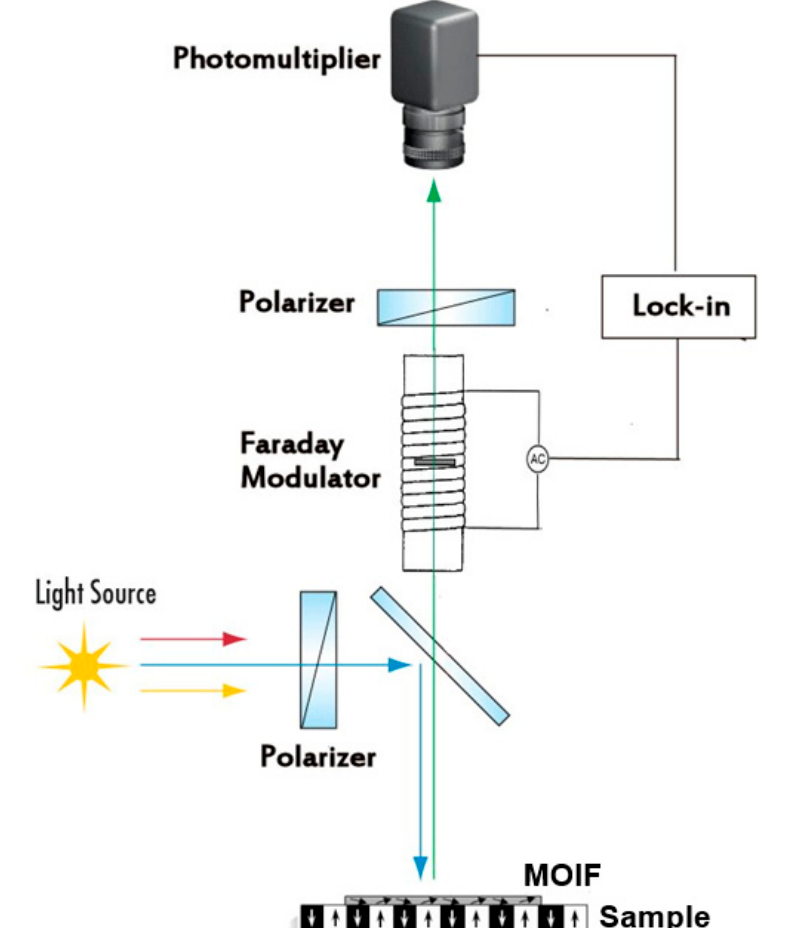
Figure 2. Schematic diagram of magneto-optical setup. The role of the Faraday modulator is explained in Section 5.3 below. The blue arrows indicate the incident polarized light and the green arrow indicates the light reflected back from the MOIF’s mirror layer. (The red and yellow arrows just indicate that the light is not monochromatic.)